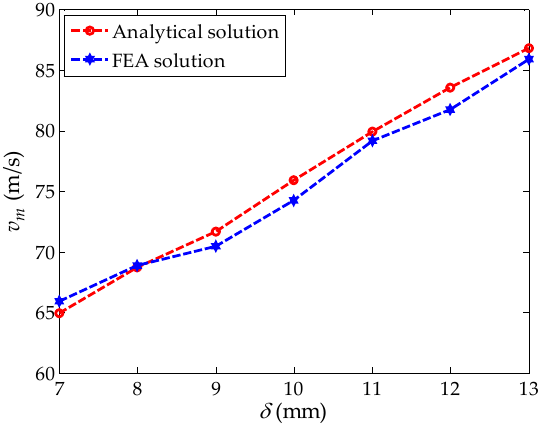
Figure 8. The critical speed varying with the air gap length.